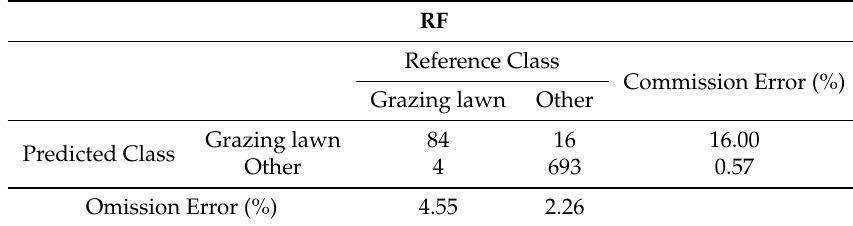
Table A2. Confusion matrix summarising results from Random Forest (RF) model classification of grazing lawn and other cover.